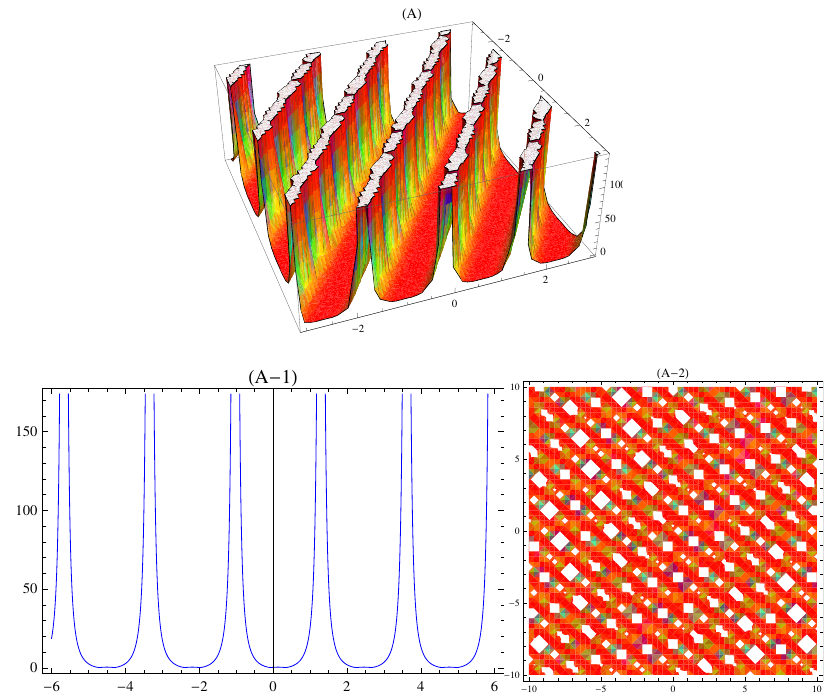
Figure 1: (A) 3D graph of (13) with α = 2.3 , 𝛾 = 1.5 , θ = 1.3 , λ = 0.4 , µ = 0.7 , Θ = 0.7 , w = 2 , p = 0.98 , q = 0.95 , k = 2 , A = 3 , δ = 2 , ς = 1.9 , τ = 0.85 , c = 4 , z = 3 , ϵ = 2 , y = 2.6 . (A-1) 2D plot of (13) with t = 1 . (A-2) Contour graph of